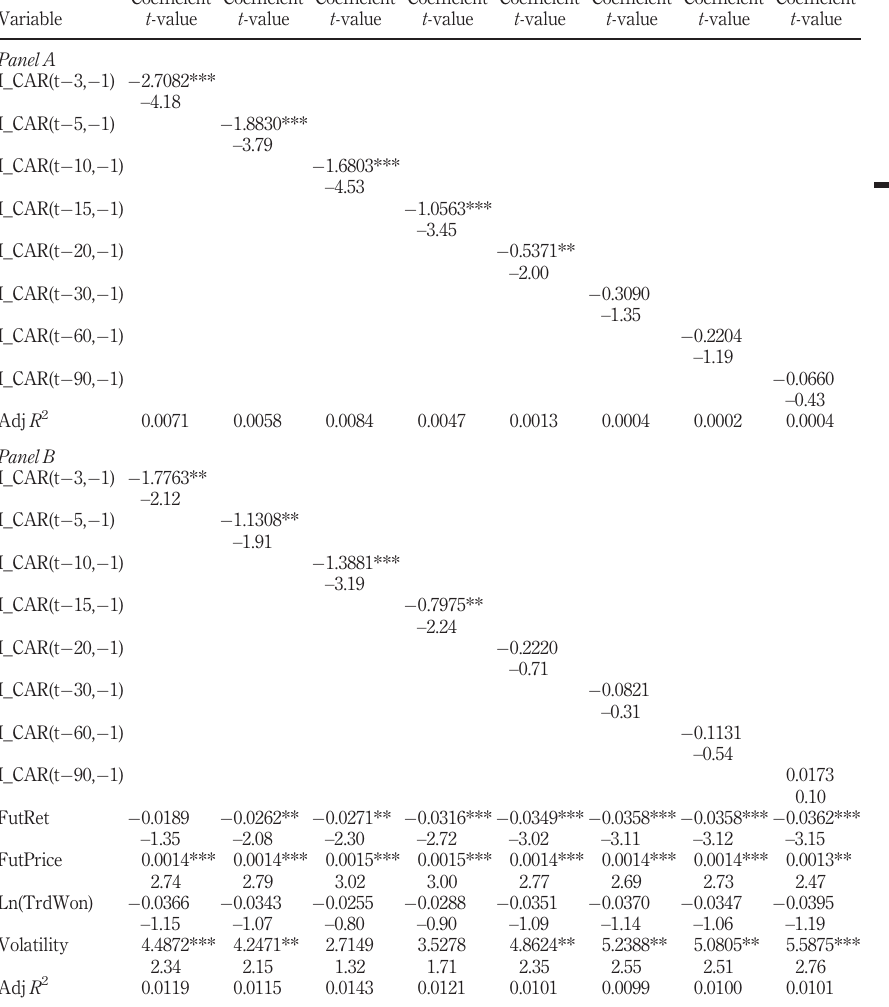
Table 4. Effect of the